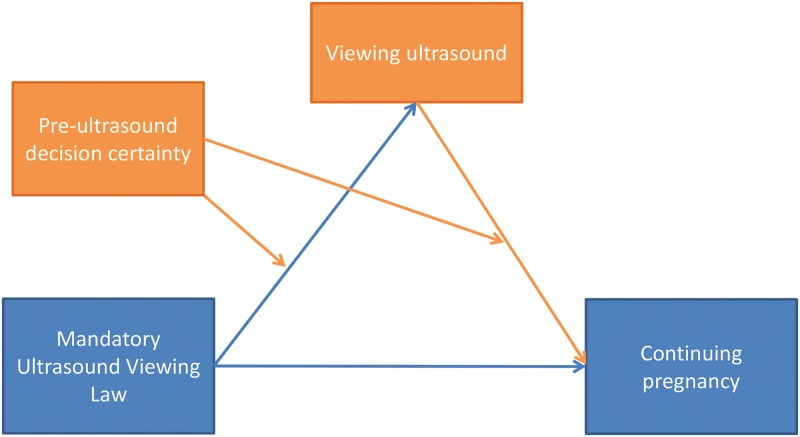
Conceptual model.